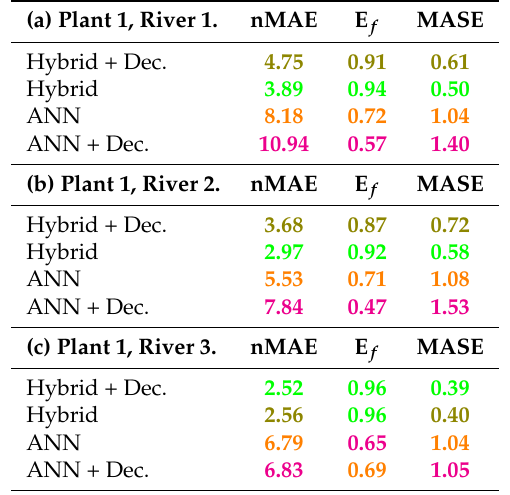
Table 3. Performance comparison proposed method and the three benchmarks considered: Hybrid with decomposition, Hybrid, ANN, and ANNs with decomposition for three of the analyzed plants: worst result: green, olive, orange, and